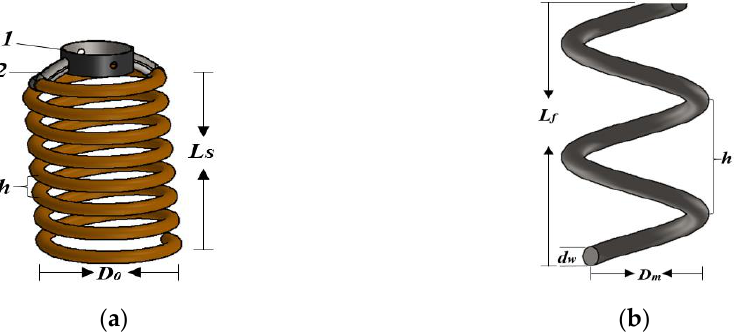
Figure 2. Structural schematics of springs: ( a ) SMA spring with cylindrical mounting 1 on the hook end 2; and ( b ) bias